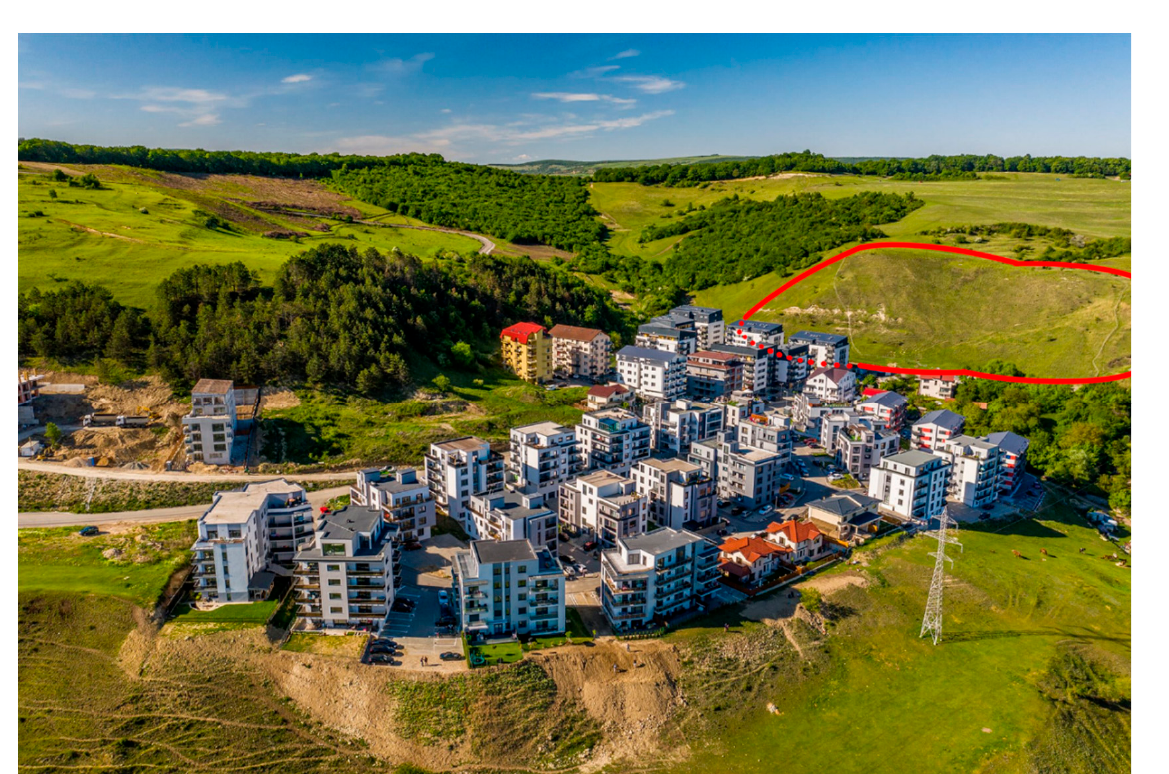
Figure 2. Aerial photo of the emerged residential complex and monitored study